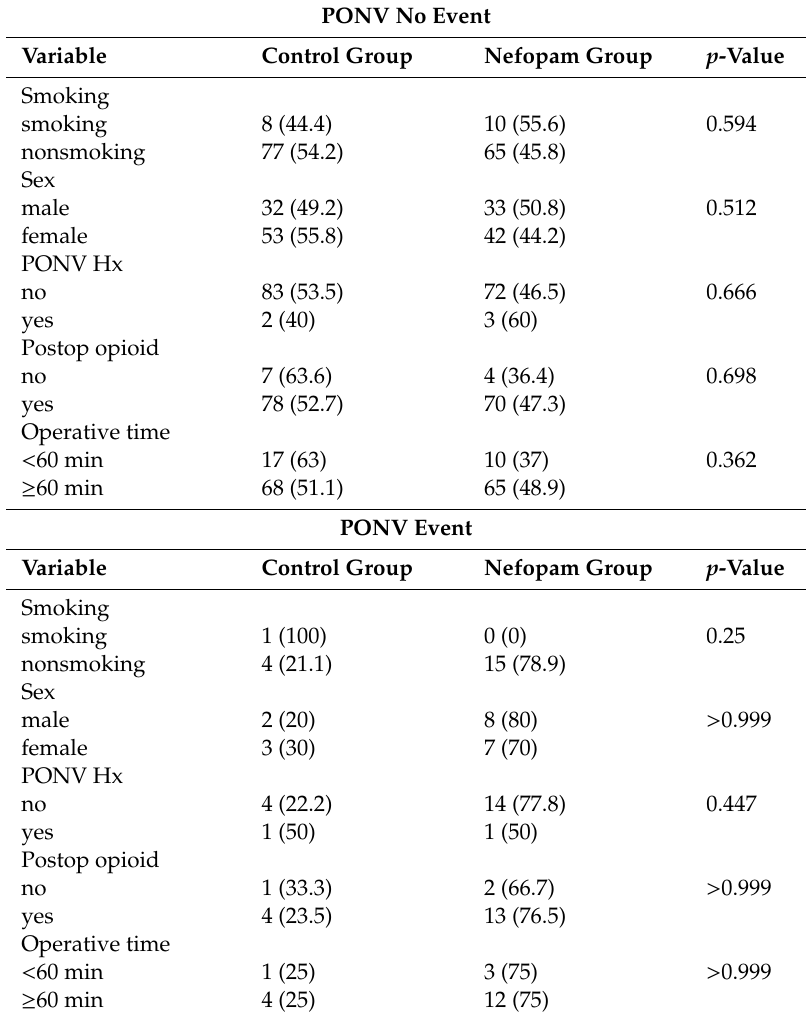
Table 7. PONV risk factors associated with PONV and